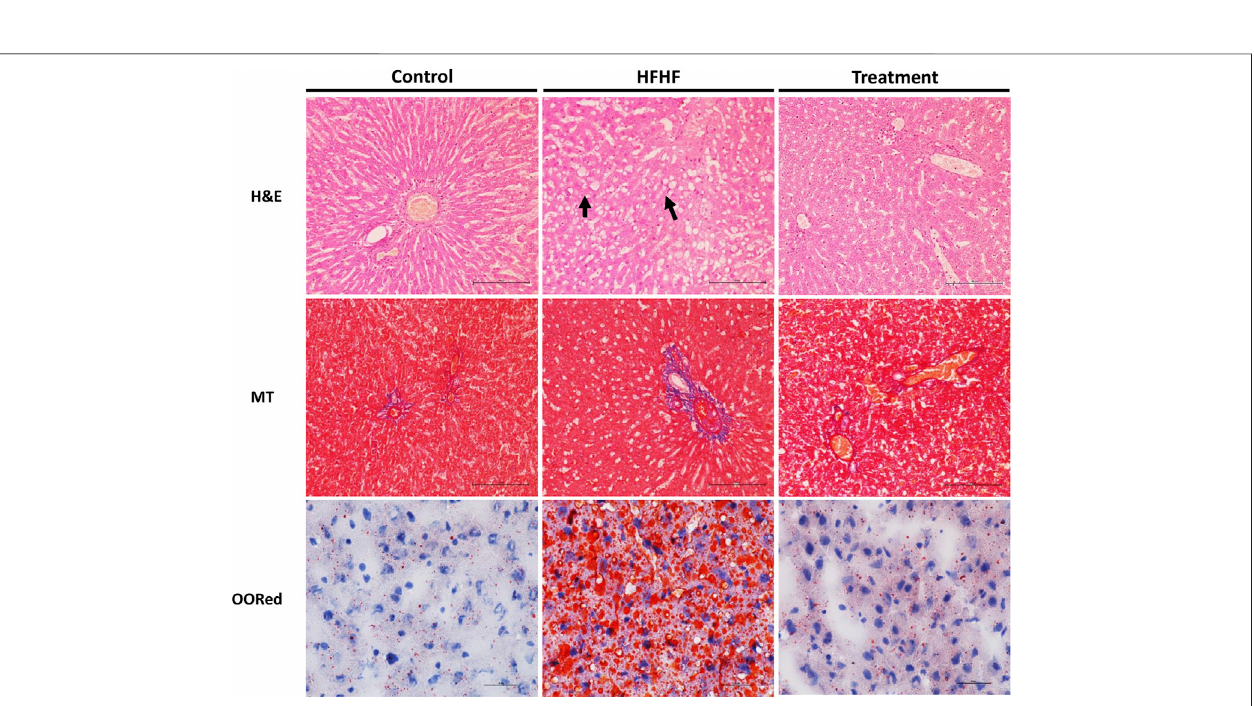
Frontiers in Pharmacology |